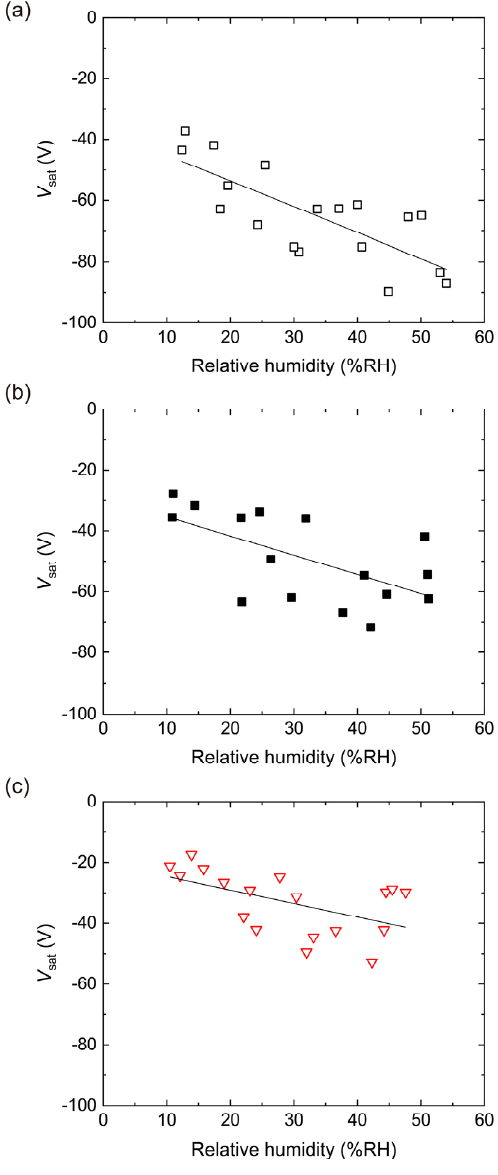
Figure 7. Plots of V sat versus relative humidity for PES films doped with 1 wt% ( a ), 5 wt% ( b ), and 10 wt% ( c ) AMO